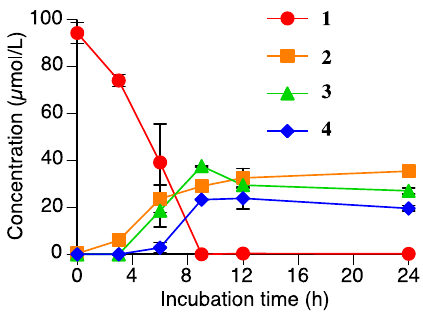
Figure 6. Time-dependent accumulations of naringenin ( 2 ), sakuranetin-4 ′ - O - β - D -xylopyranoside ( 3 ), and naringenin-7- O - β - D -xylopyranoside ( 4 ), and the decreasing sakuranetin ( 1 ) content in the Rhizoctonia solani suspension culture. Values are presented as the mean ± SD ( n = 3).